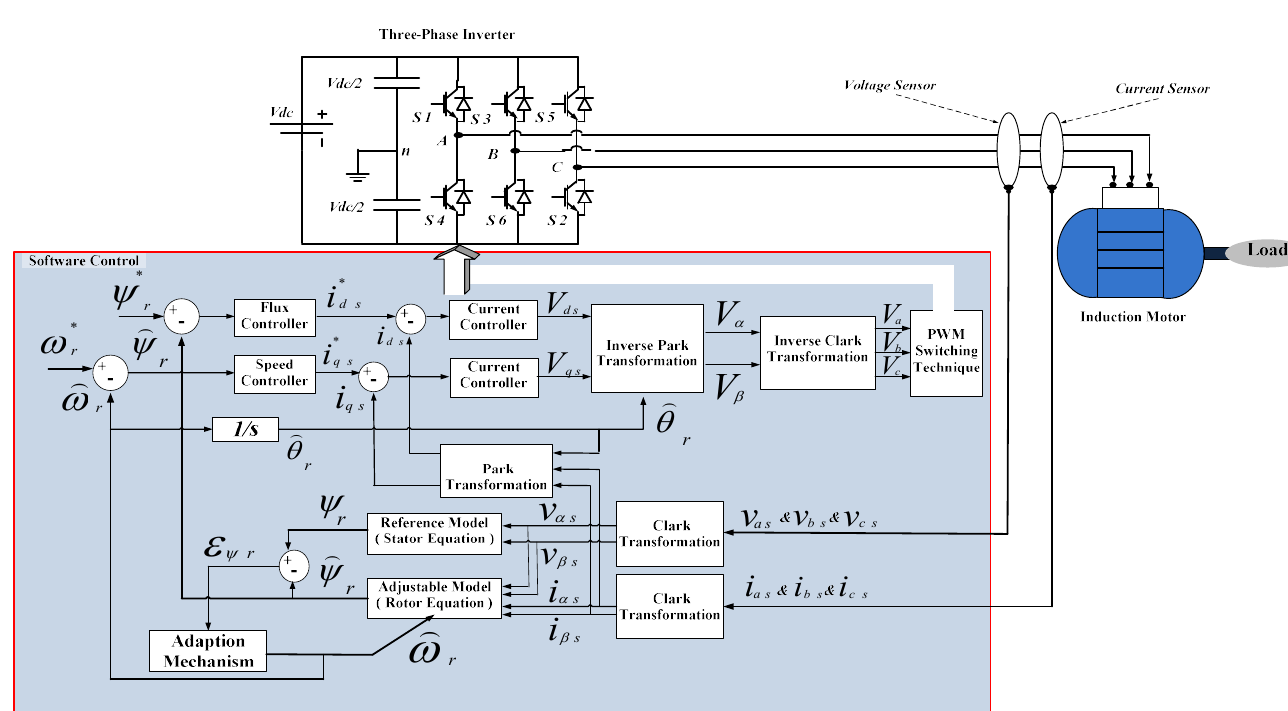
Figure 16. IFOC block diagram for IM drive based on MRAS.